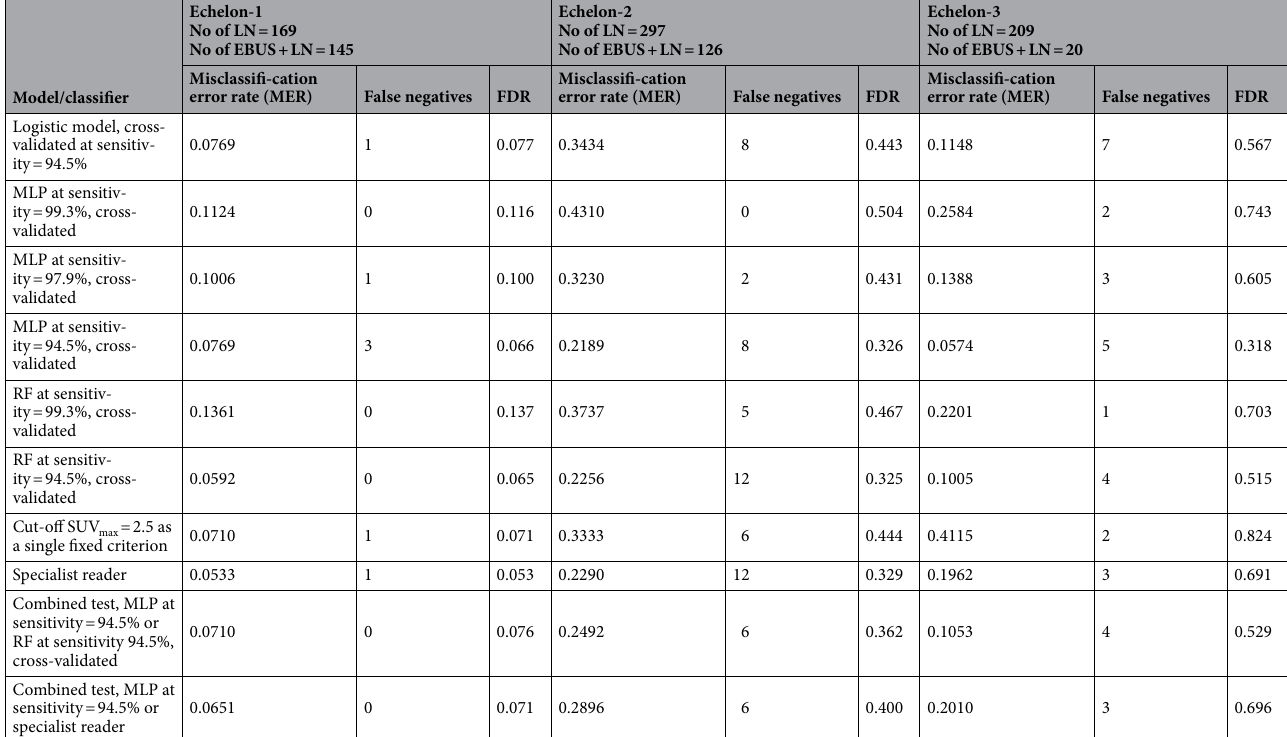
Table 5. Determination of misclassification and false discovery rate in echelon-1 to -3 with each test procedure. MLP multilayer perceptron neural network, RF Random forest, LN lymph node, FDR false discovery